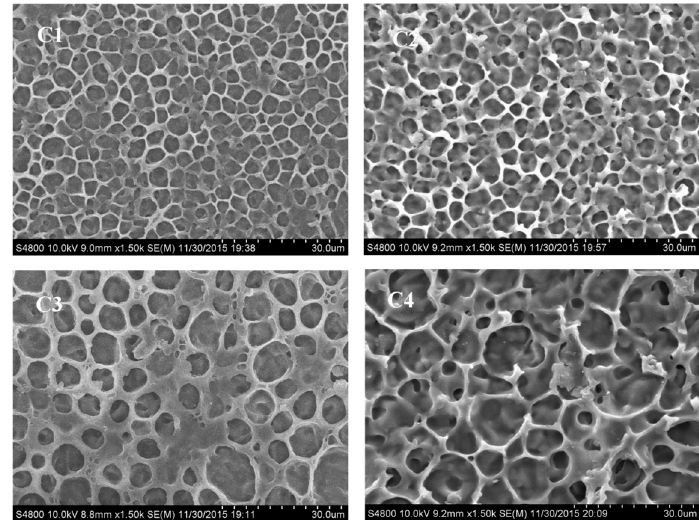
Figure 7. SEM micrographs of the polymer network in the samples C1–C4.